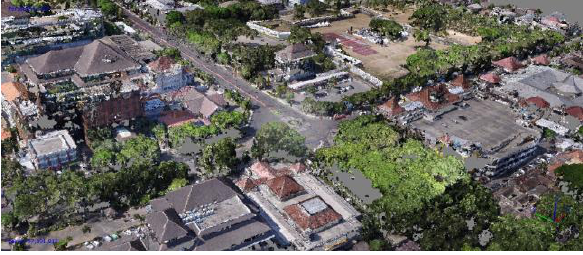
Figure 2. Dense Point Cloud obtained from SfM Processing with Agisoft Metashape